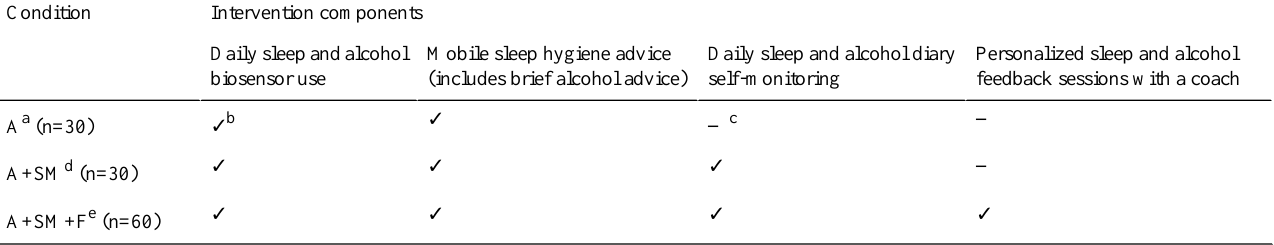
Table 1. Intervention conditions. Intervention componentsCondition